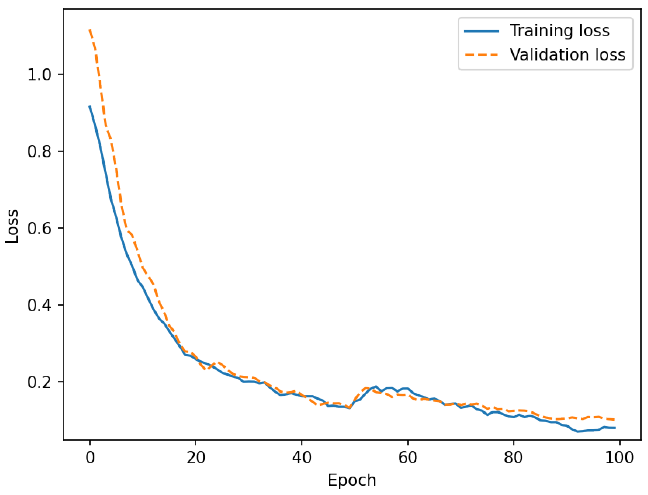
Figure 2. Loss function value curves of Improved